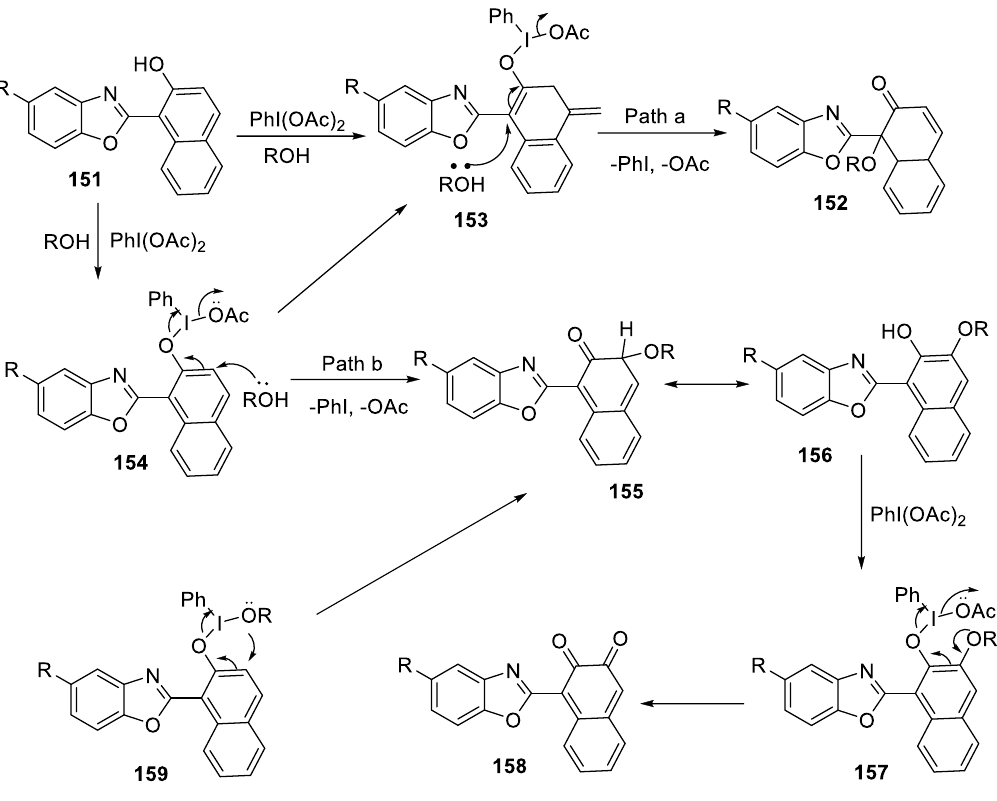
Figure 21. Plausible mechanism for the formation of dearomatized products.